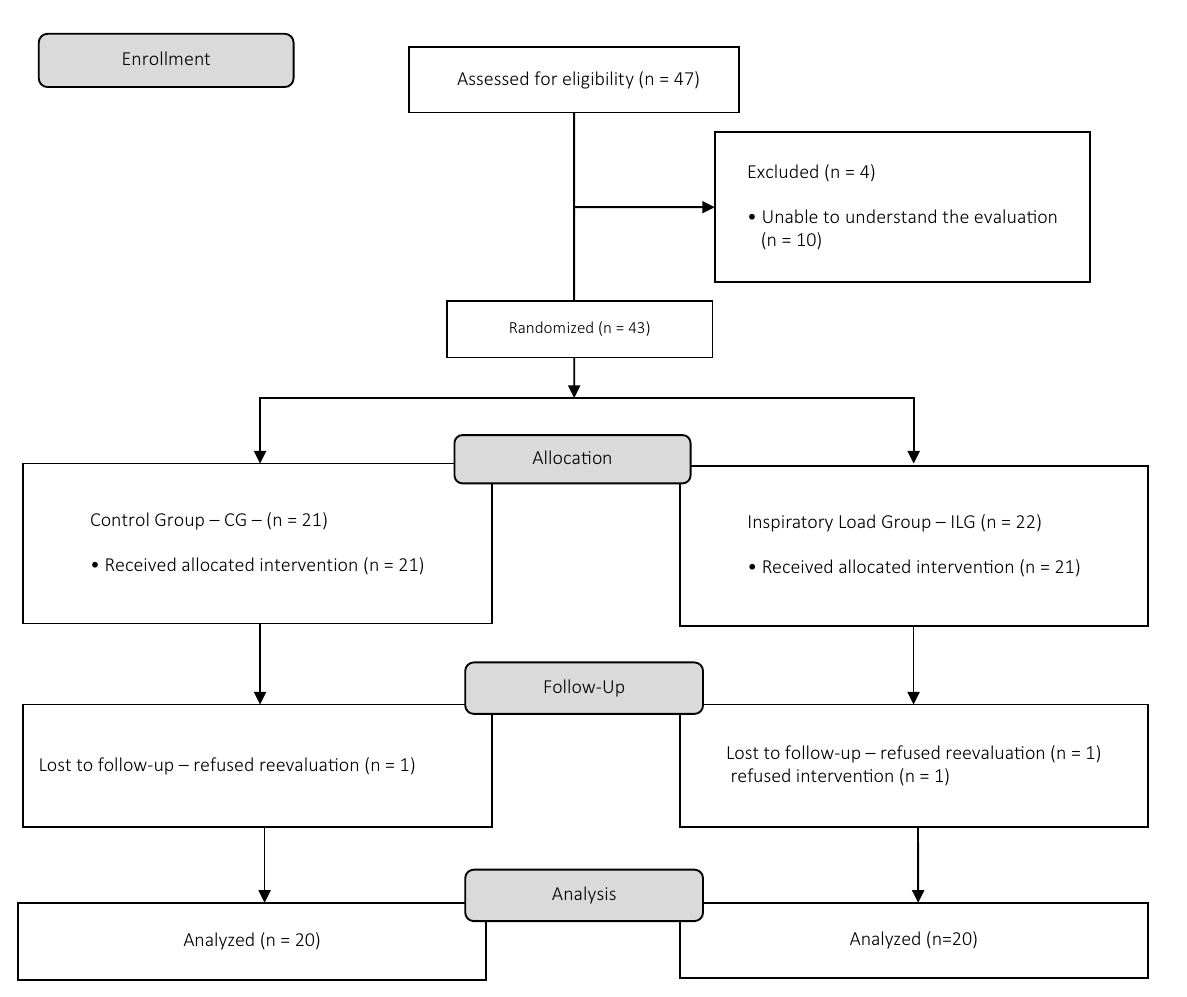
Figure 1 – Flowchart of the study design according to CONSORT.